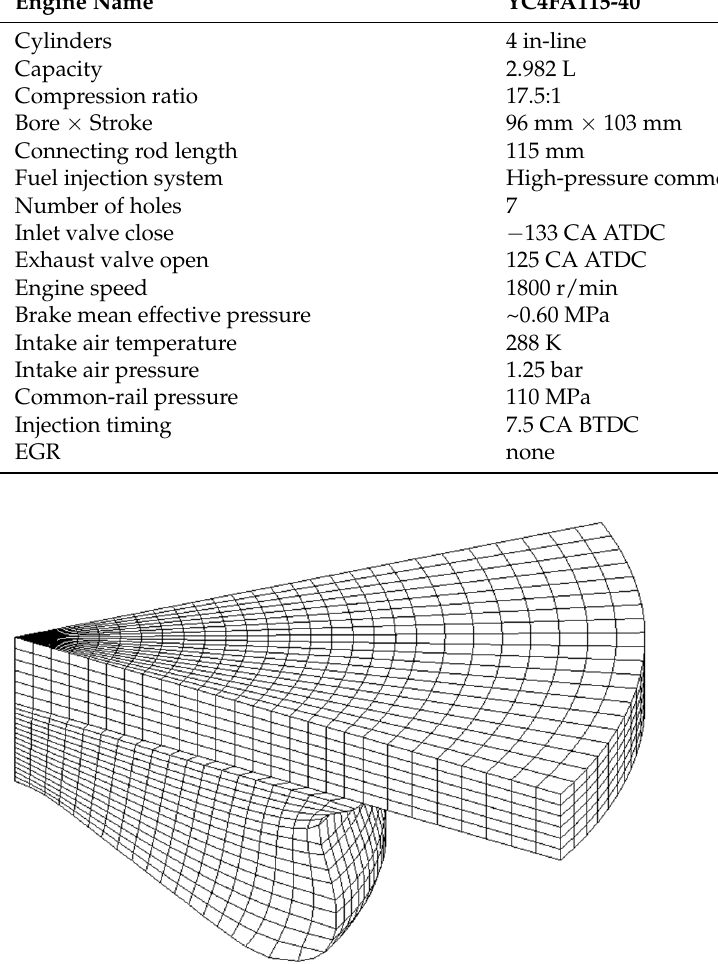
Figure 13. Measured and predicted in-cylinder pressure and HRR pro fi les. Figure 14 displays the simulated results of soot and NOx emissions using the present mechanism against the experiments. As seen, both simulated and experimental data indi- cate that the soot emission level of diesel is obviously higher than DMF30 as there is more carbon content and less oxygen content in the diesel fuel, while DMF30 produces more NOx emissions compared with diesel due to the enhanced premixed combustion, which is consistent with other studies [14,23]. In general, the predicted soot and NOx emissions